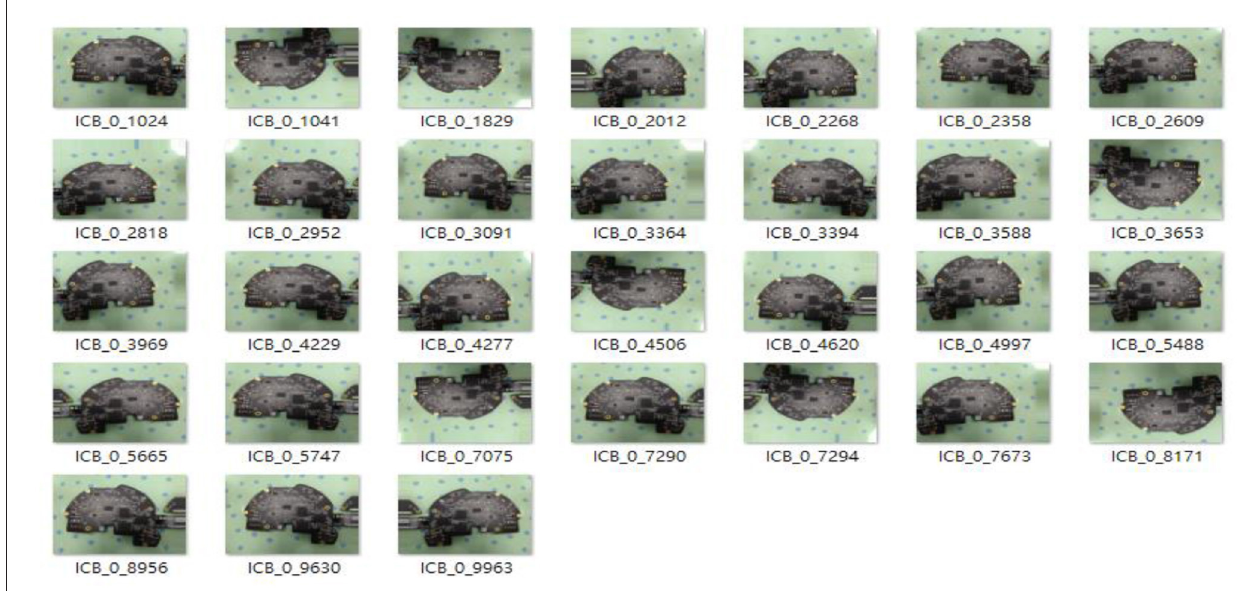
FIGURE 9 | Results of data augmentation methods.